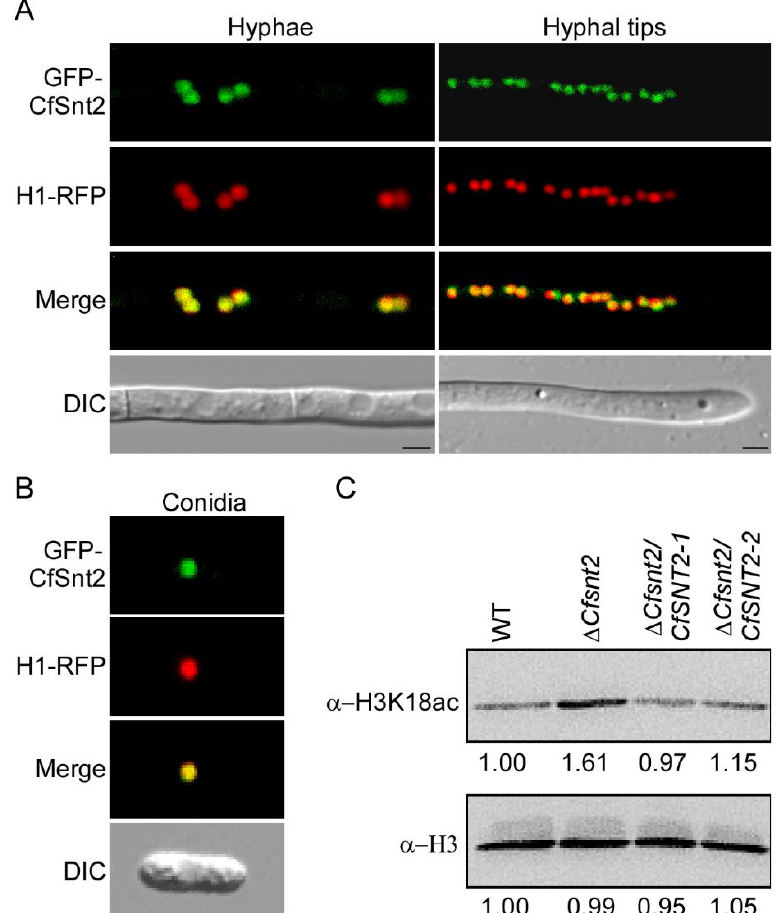
Figure 1. CfSnt2 is localized to the nucleus and mediates the deacetylation of H3K18. ( A ) The localization pattern of CfSnt2 in the mid and tip regions of the hyphae. The merged images of GFP-CfSnt2 and H1-RFP indicated that GFP-CfSnt2 is localized to the nucleus. ( B ) Localization pattern of CfSnt2 in conidia. Bar = 5 μm. ( C ) Total proteins extracted from mycelia of WT, ΔCfsnt2 mutant and complemented strains Δ Cfsnt2/CfSNT2-1 and Δ Cfsnt2/CfSNT2-2 were immunoblotted with the anti-H3K18ac and anti-H3 antibodies. The intensity of the protein bands were analyzed by Image J, and the intensity of WT was defined as a reference, with 1.00.